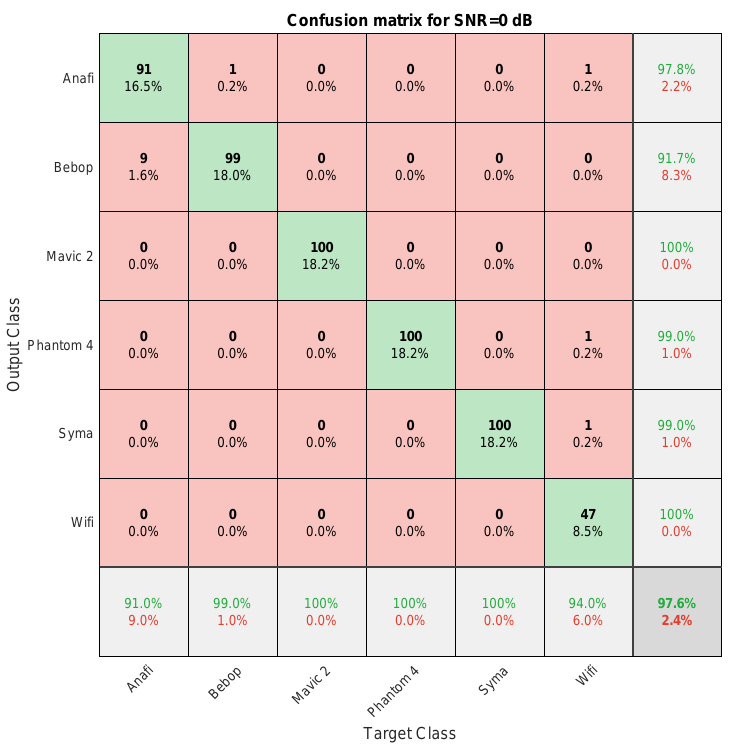
Figure 7. Confusion matrix (SNR = 0 dB). A green case corresponds to good classifications and a red case corresponds correspond to wrong